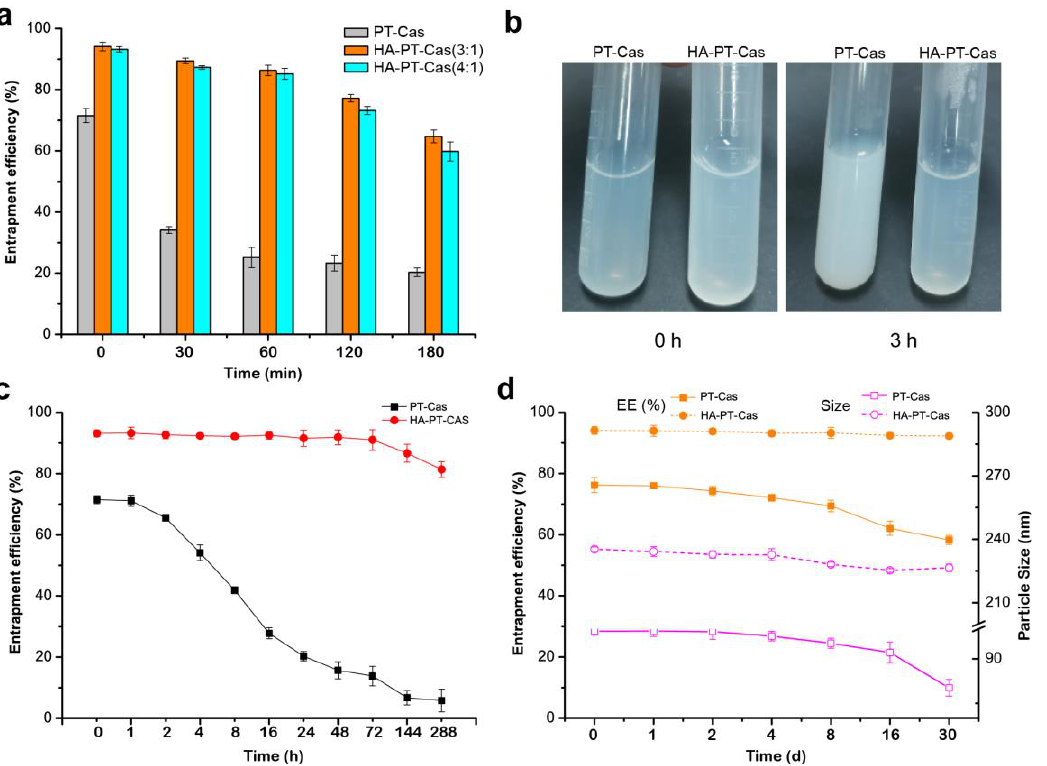
Figure 2. Investigation of the stability of HA-PT-Cas nanoparticles. Effects of the HA/casein values on the stability of entrapment efficiency ( a ) and turbidness ( b ) of nanoparticles incubated in 37 °C. ( c ) The entrapment stability of PT-Cas and HA-PT-Cas nanoparticles stored at 4 °C for 288 h; ( d ) Effects of lyophilization storage for 30 days and redissolution on the entrapment efficiency and particle size of nanoparticles.